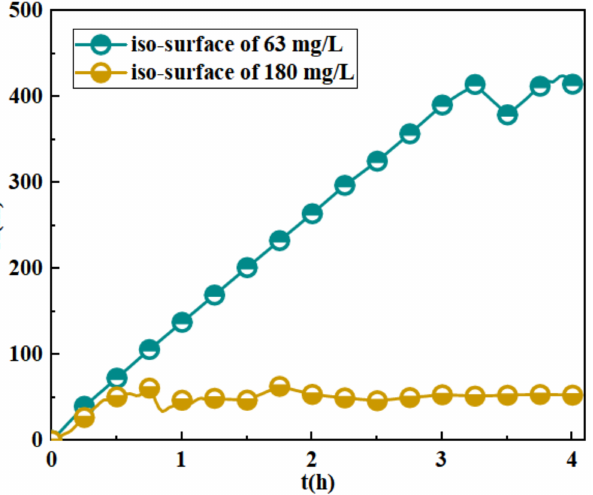
Figure 10. Change of the position of the iso-surface of different concentration along x -axis at M s = 0.63